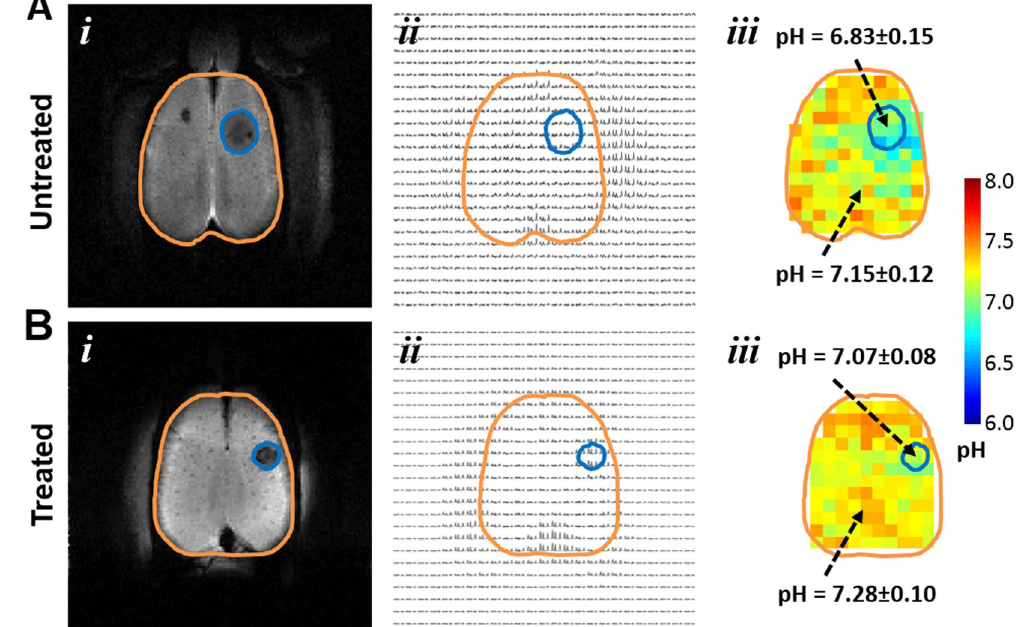
Figure 2. Representative pH e maps from BIRDS in untreated (A) and TMZ treated (B) rats bearing U251 tumors. (i) The T 2 -weighted images identify the tumor boundary (tumor = blue outline; brain = orange outline). (ii) CSI data for corresponding slice in (i) shows varying TmDOTP 5 − levels throughout the brain. (iii) Quantitative pH e maps were obtained using multiple TmDOTP 5 − peaks and the intratumoral and peritumoral pH e average values and their standard deviations (SDs) are indicated. In untreated rats, the tumor is larger and the intratumoral pH e is acidic and spreads beyond the tumor boundary. In treated rats, the tumor is smaller and the intratumoral pH e is near neutral with lower pH e localized within the tumor boundary.